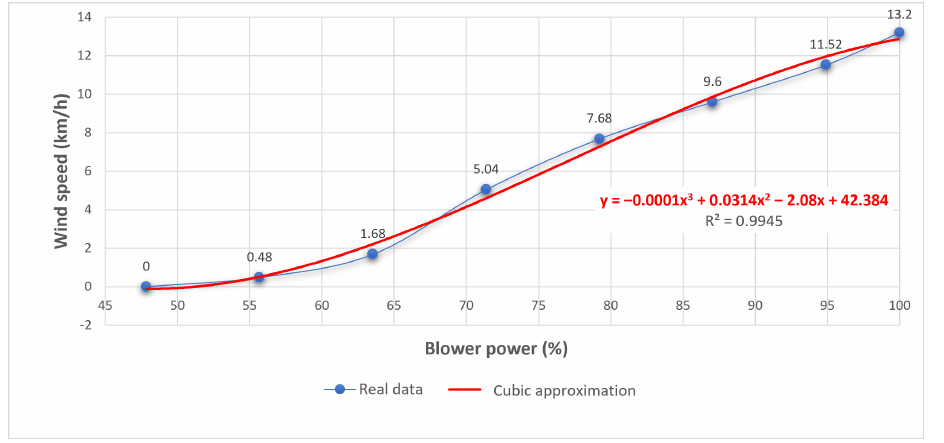
Figure 18. Cubic regression vs real data.